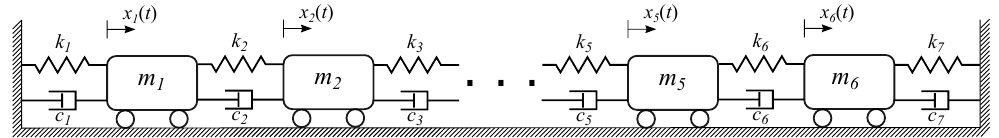
Figure 2. 6-degrees of freedom (DOF) structural system with m i = 10 2 kg, c i = 2 × 10 2 Ns/m and temperature-varying stiffness K i .